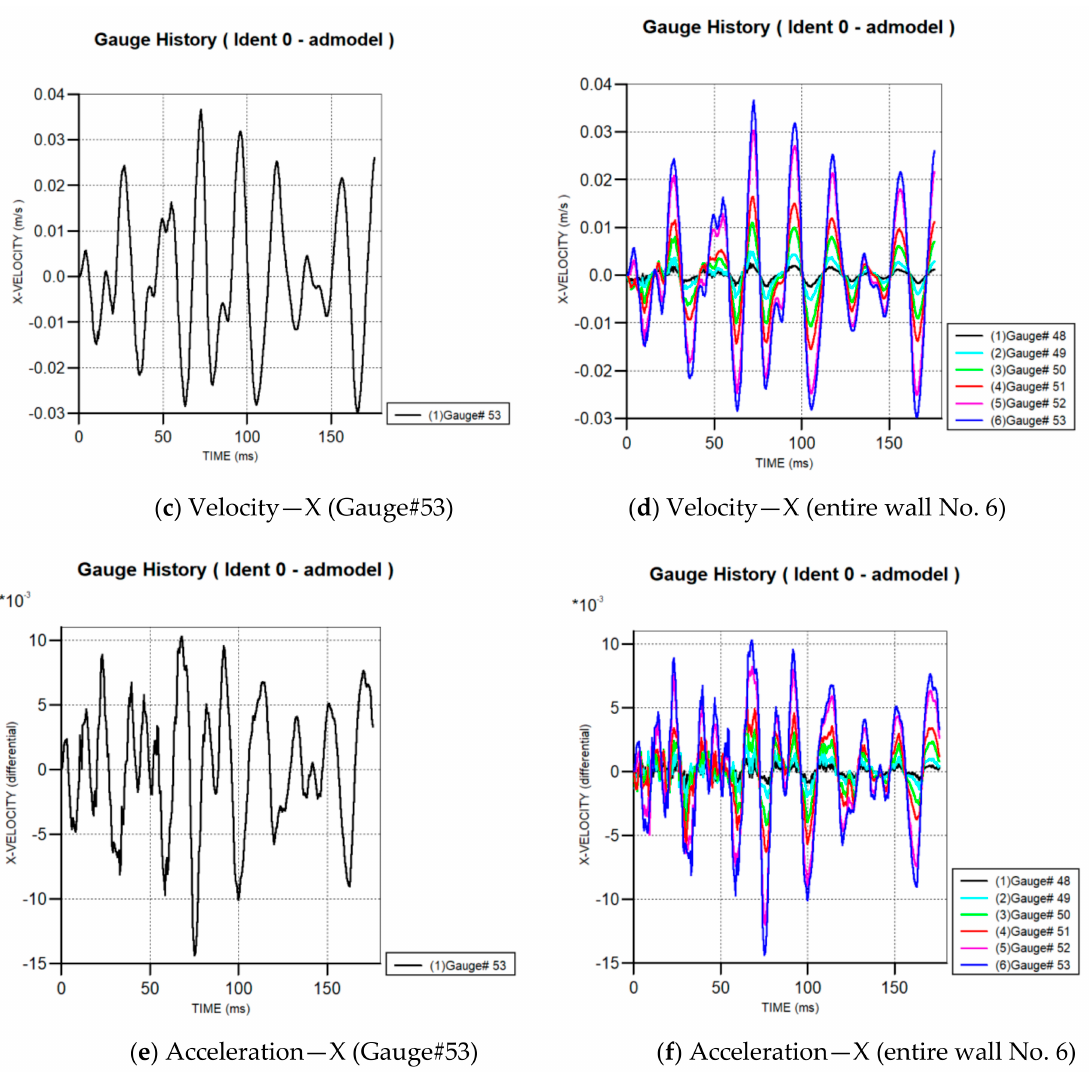
Figure 10. Displacement, velocity, and acceleration at certain sensors for Case 1.